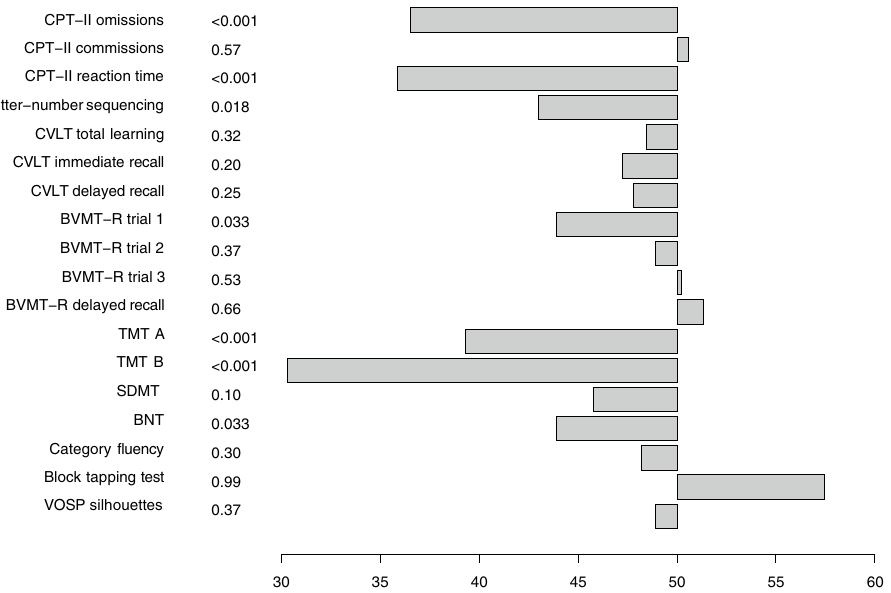
Figure 2. Neuropsychological test results for the total study group, presented as T-scores. P-values indicate difference between study group and normative